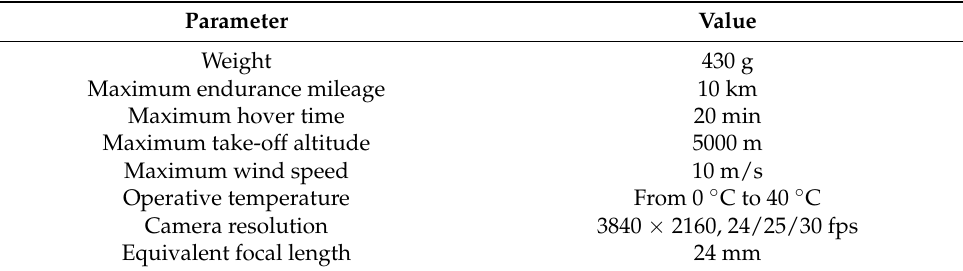
Table 3. Parameters of DJI MAVIC 2 Pro